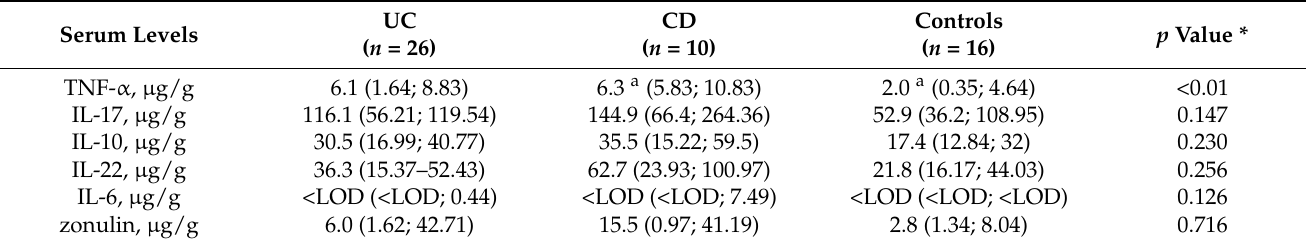
Table 3. Cytokine and zonulin levels in patients with ulcerative colitis (UC), Crohn’s disease (CD), and